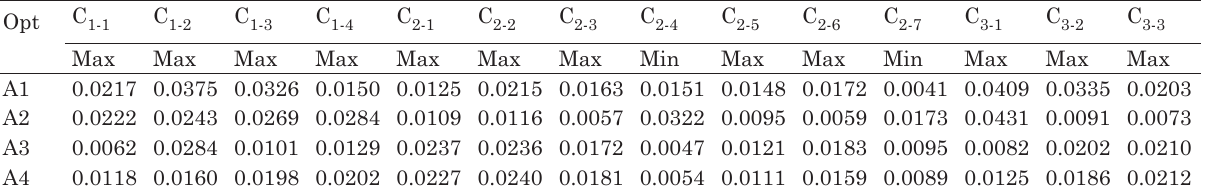
Table 9. Weighted normalized matrix Opt C 1-1